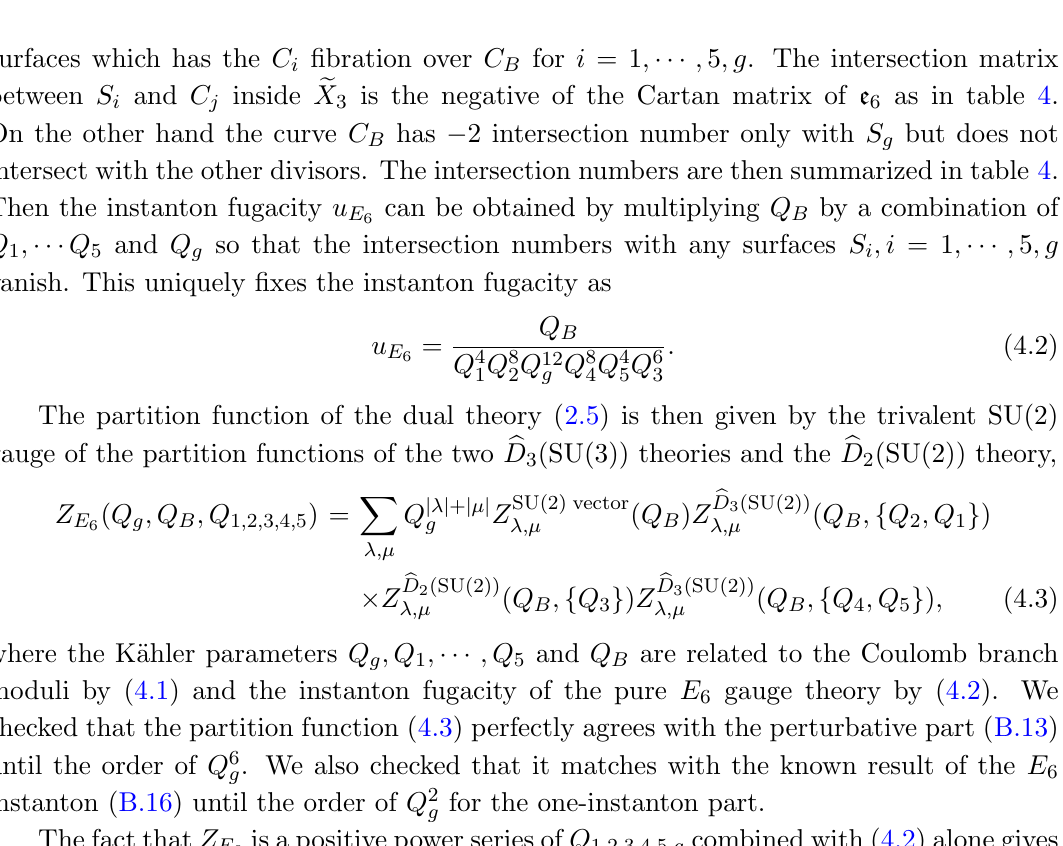
Table 4 . The matrix of the intersection numbers between the divisors S i ; i = 1 ; curves C i ; i = 1 ; ; 5 ; g; B (cid:1) (cid:1) (cid:1)